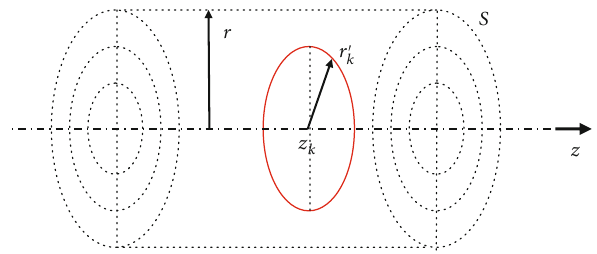
Figure 1: The geometry of the fl uid boundary and equivalent